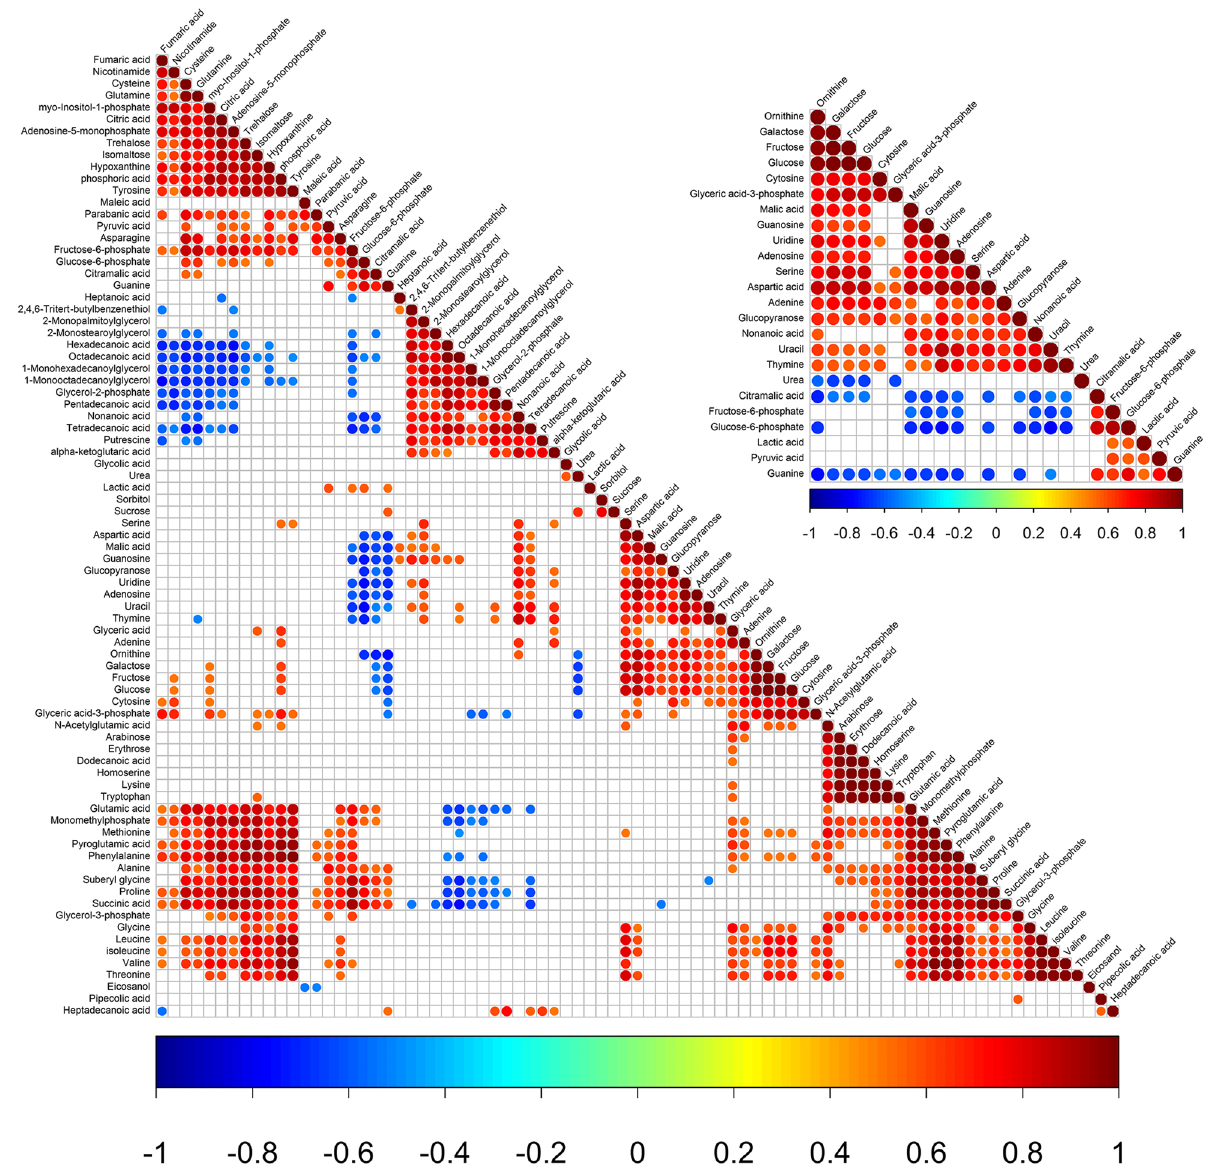
Figure 2. Metabolite-metabolite correlation analysis. Blank squares: p > 0.05. Marked with red or blue (p < 0.05) are the significant metabolite-metabolite correlations. Positive correlations are shown in red; negative correlations are shown in